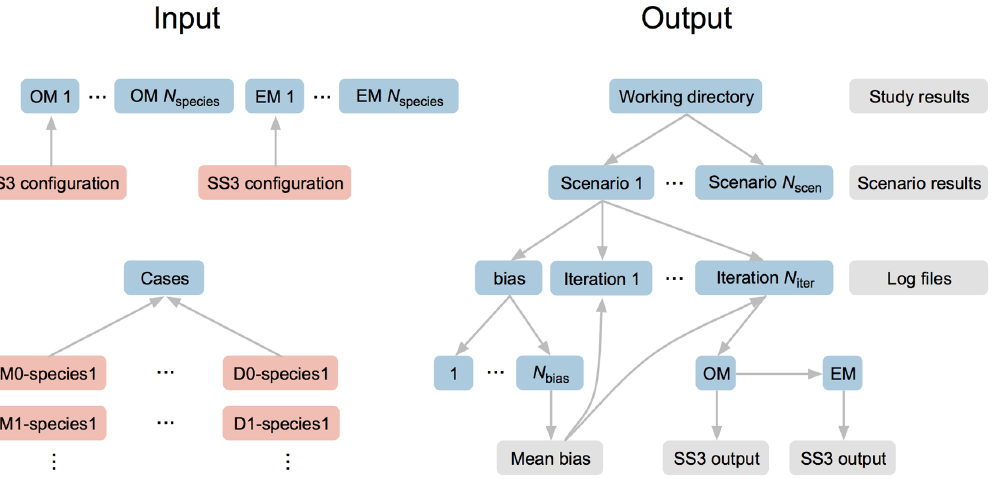
Figure 2. Illustration of input and output folder and file structure for an ss3sim simulation. Folders are shown in blue, input files in orange, and output files in grey. All input and output files are in plain text format. OM refers to operating model and EM to estimation model. Case files (orange files at bottom left) combine cases (e.g. M0 for a given natural mortality trajectory) with species or life-history OMs and EMs (e.g. cod-like or sardine-like). Alternatively, a user can skip setting up case files and specify the simulation cases directly in R code (see the